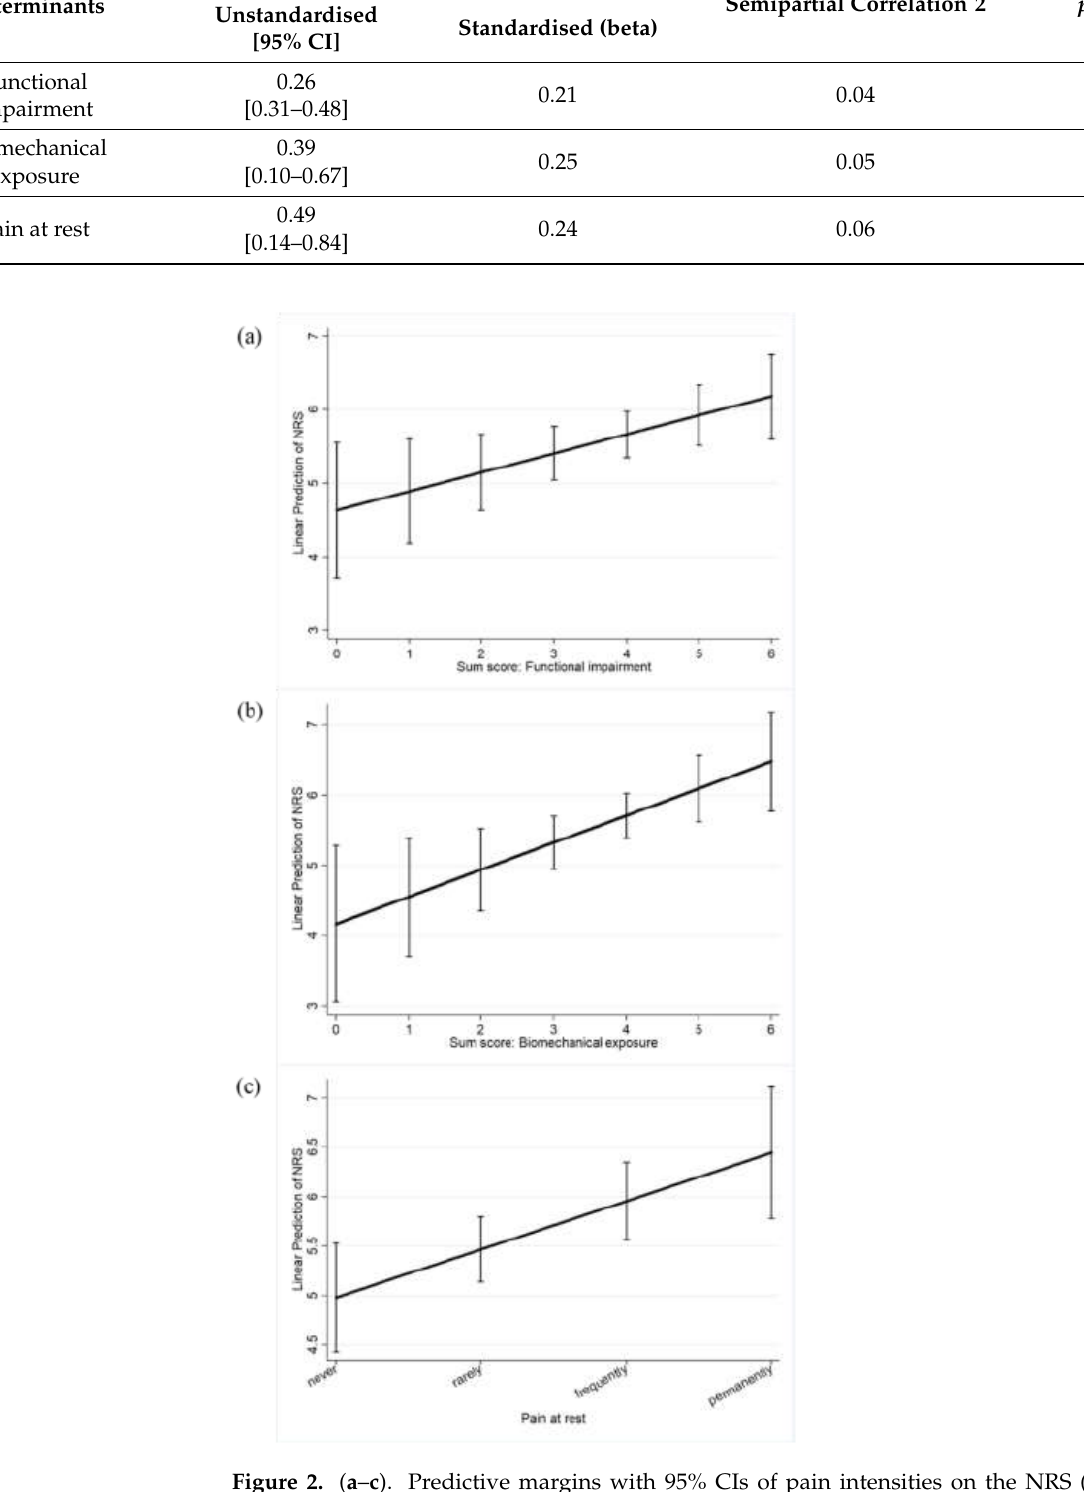
Figure 2. ( a – c ). Predictive margins with 95% CIs of pain intensities on the NRS (0 = no pain; 10 = worst conceivable pain) for the determinants ( a ) functional impairment, ( b ) biomechanical exposure, and ( c ) pain at